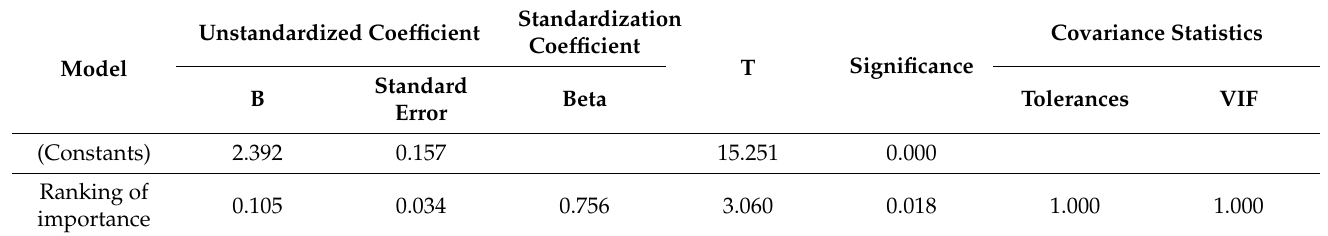
Table 8. Coefficient a .